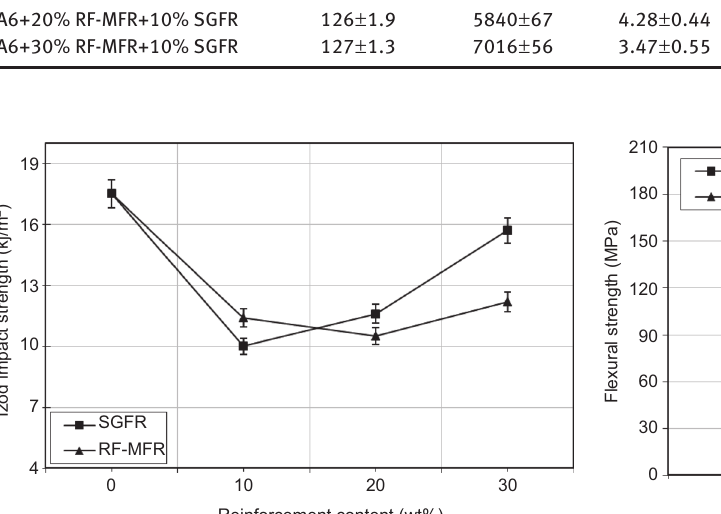
Figure 7 Variation of the flexural modulus of PA6 with weight percent of reinforcement content.